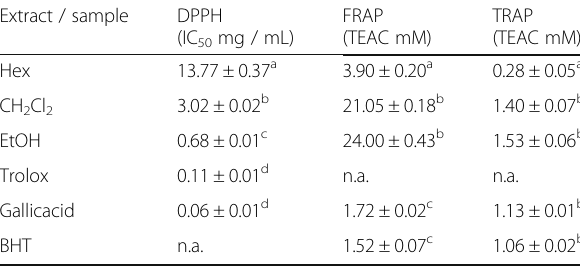
Table 2 Antioxidant activity of the aerial part of E. chilensis extracts and positive controls Extract / sample